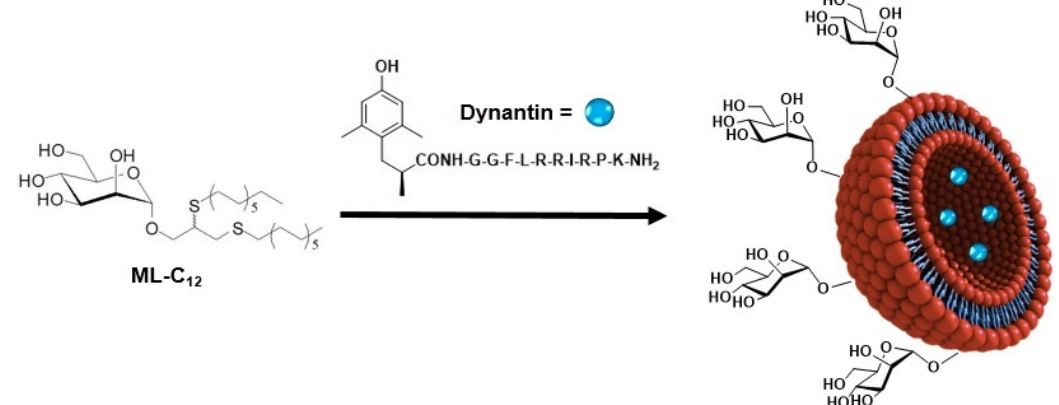
Figure 1. Schematic representation of mannosylated liposomes ML-C 12 for the encapsulation of Dy- nantin.